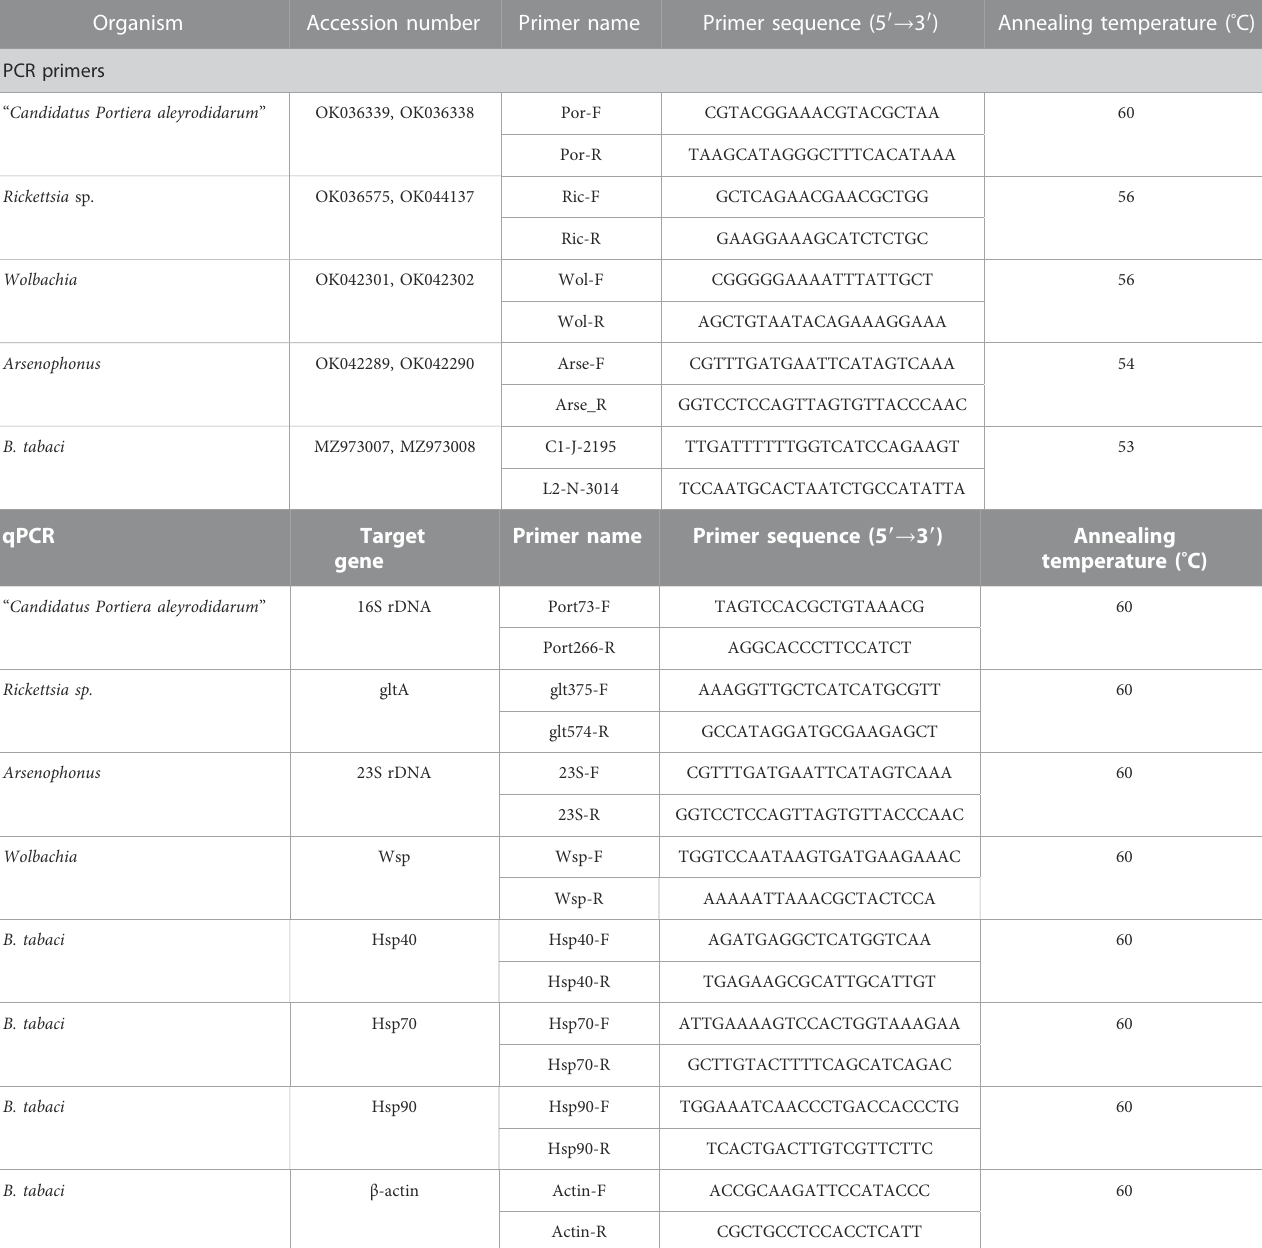
TABLE 1 Primers used in the current study. The primer name, accession number, primer sequence, and annealing temperature are listed in the table.